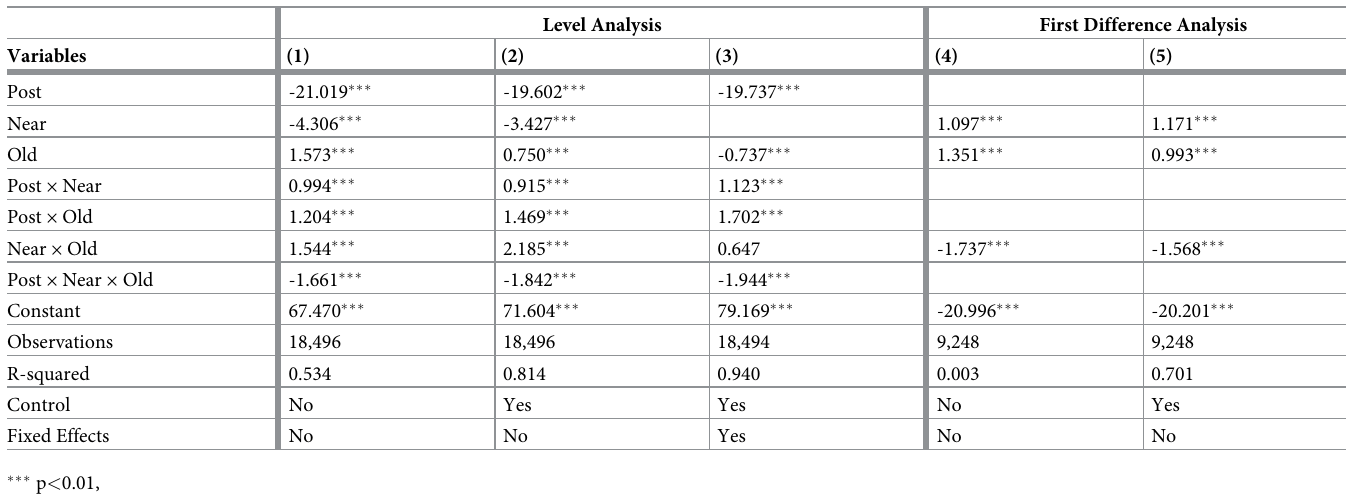
Table 1. Triple difference estimation